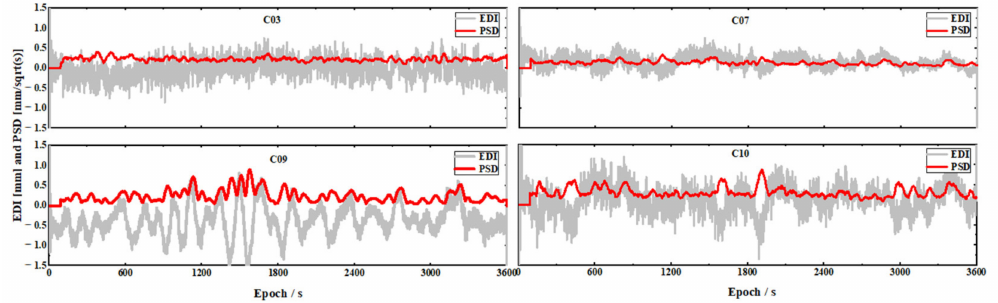
Figure 5. Correlation between EDI and PSD.